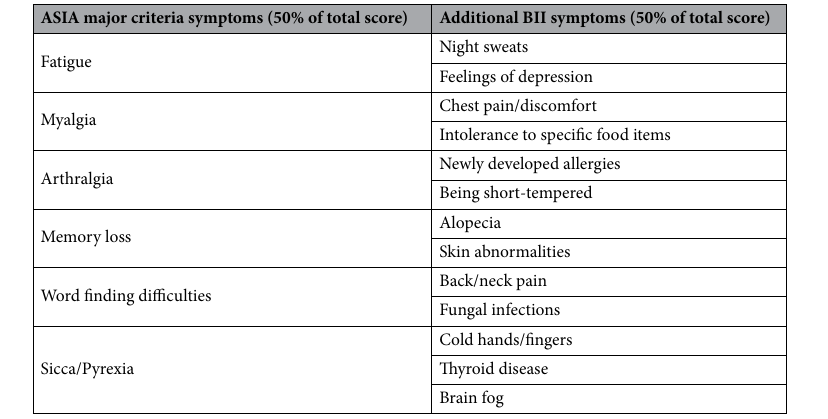
Table 7. Novel ASIA-scale symptom survey and respective weight for summary